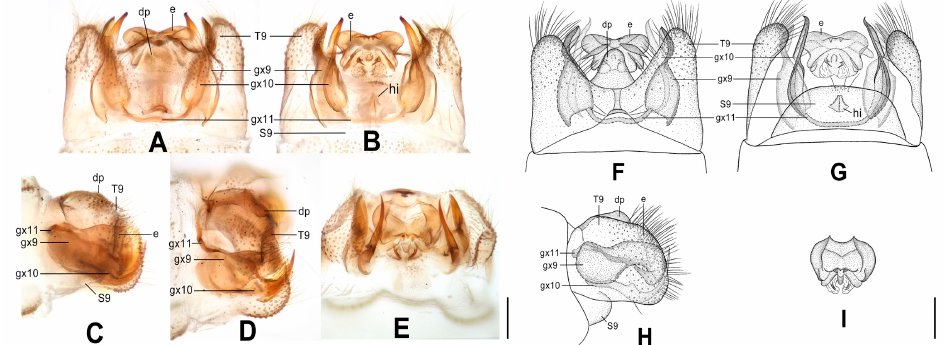
Figure 14. Dilar yucheni sp. nov. ( A – E ) male holotype, genitalia, photographs: ( A ) dorsal view; ( B ) ventral view; ( C ) lateral view; ( D ) dorsolateral view; ( E ) caudal view. ( F – I ) male holotype, genitalia, line drawings: ( F ) dorsal view; ( G ) ventral view; ( H ) lateral view; ( I ) ectoproct, caudal